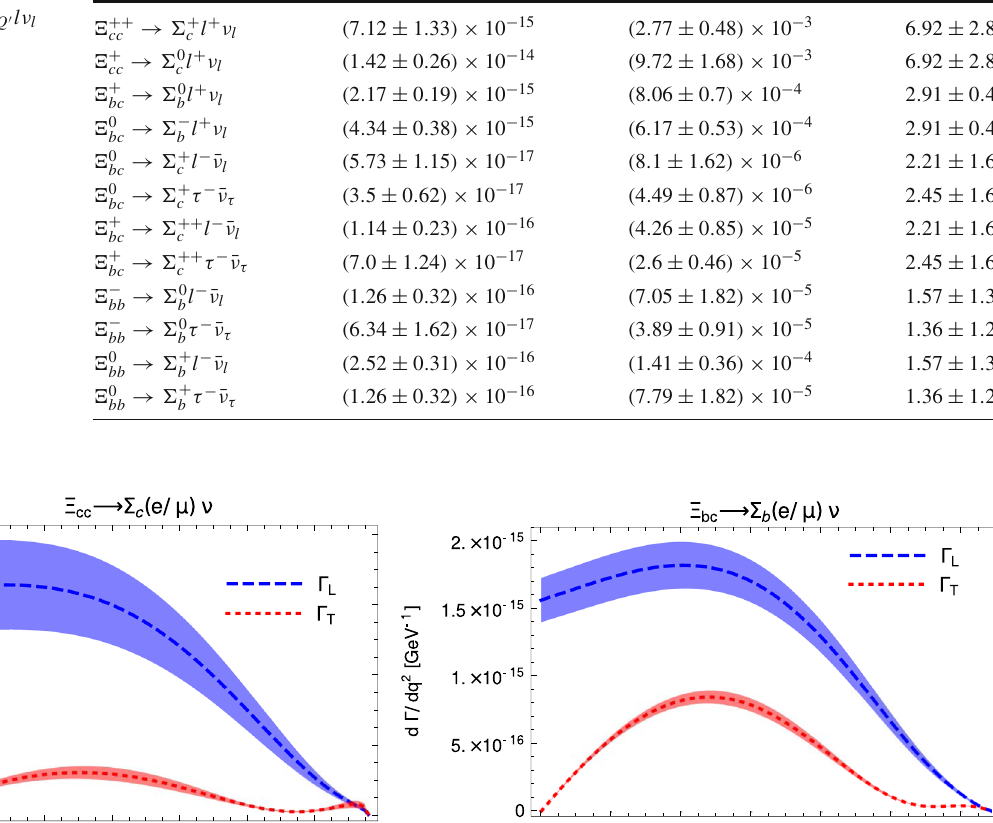
branching ratios of the semi-leptonic (cid:2) QQ (cid:2) → (cid:3) Q (cid:2) l ν l decays, where l = e ,μ